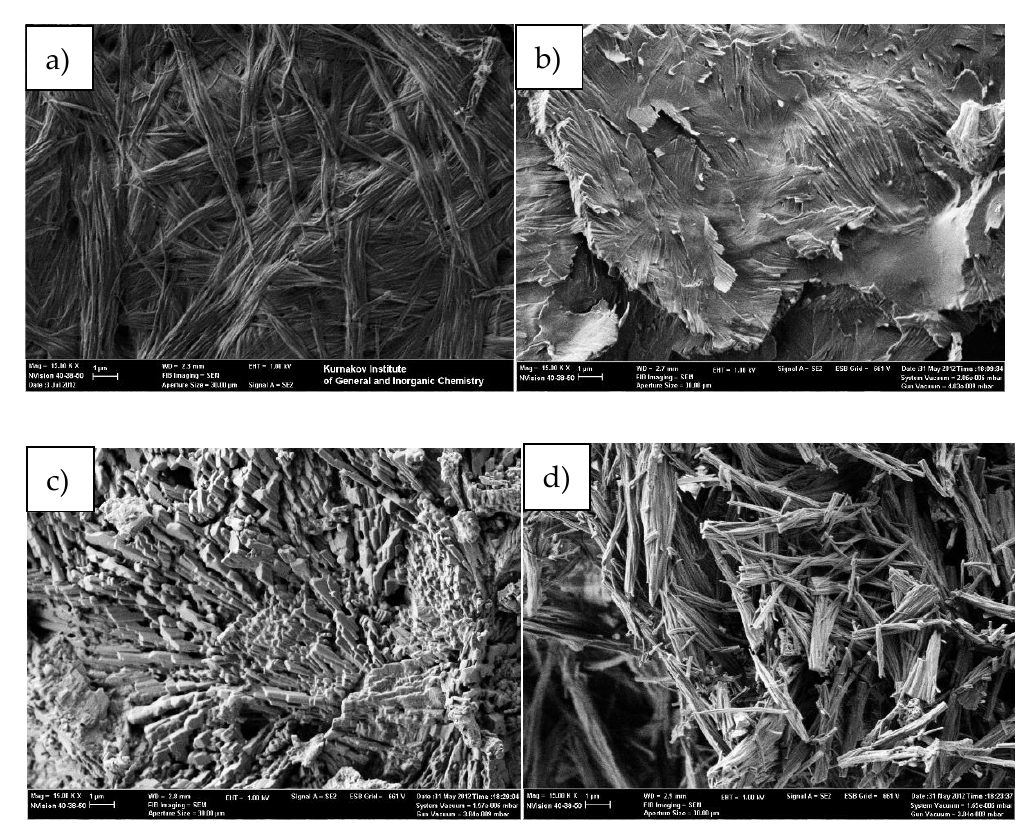
Figure 7. SEM micrographs of dry gel samples obtained by different solvent removal methods from benzene@4cb*HCl : ( a ) bulk xerogel; ( b ) gel coated on the glass surface; ( c ) liquid CO 2 washing; ( d ) sc-CO 2 washing. Scale bar is 1 micrometer.